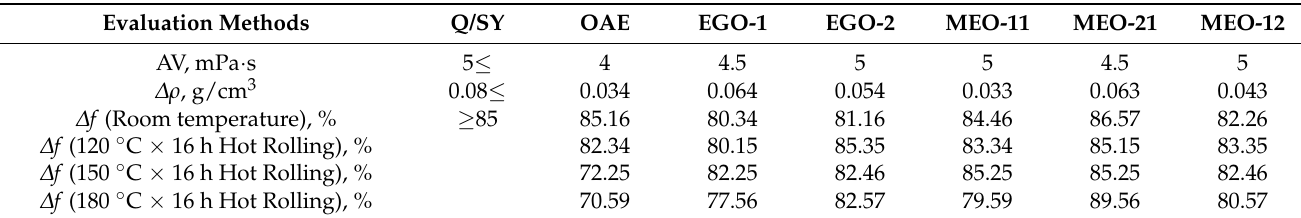
Table 2. Lubricity test results of different oleate esters.